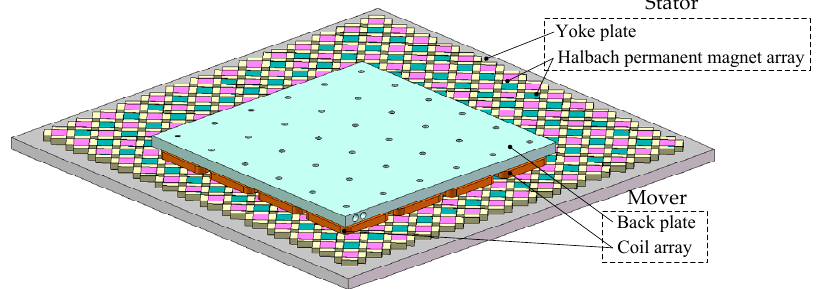
Figure 1. Maglev planar motor structure.